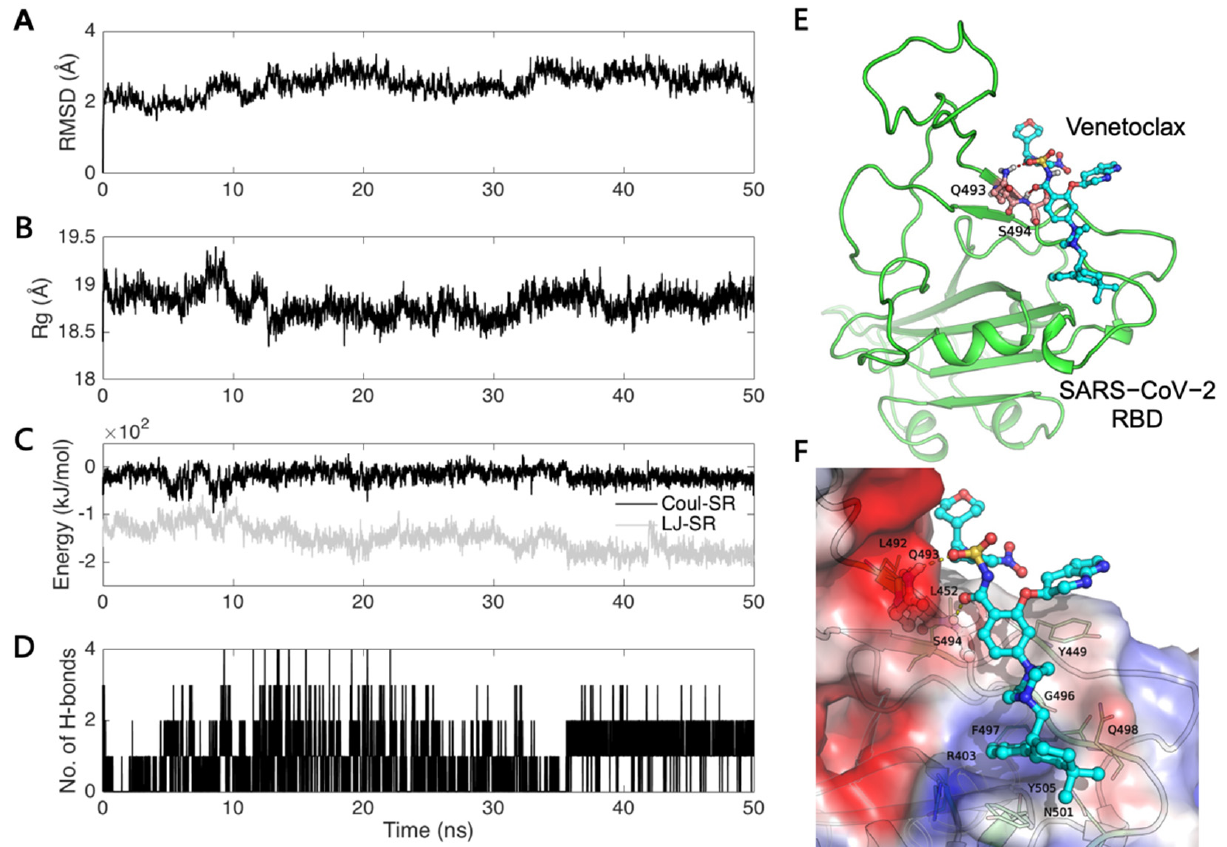
Figure 4. Analysis of the S1-RBD:Venetoclax MD simulation. The trajectory analysis of ( A ) the backbone RMSD and ( B ) the radius of gyration (Rg). ( C ) Coulomb-SR and Lennard-Jones-SR interaction energies, and ( D ) the number of hydrogen bonds of the S1-RBD:Venetoclax interface. ( E ) The last conformation of the 50 ns trajectories of the S1-RBD (green):Venetoclax (cyan) complex. The hydrogen bonds forming residues are highlighted with a ball and stick. ( F ) A close-up view of the S1-RBD:Venetoclax interface. The electrostatic potential surface of the S1-RBD:Venetoclax interface is also shown (blue: positive charge; white: hydrophobic; red: negative charge). The last conformation of the 50 ns trajectories of the S1-RBD:Venetoclax complex was chosen for the following interaction analysis (Figure 4E). The hydrogen bonds forming residues (Q493 and S494) are highlighted with a ball and stick. The key residues stabilizing the binding sites of S1-RBD:Venetoclax are identified, and the electrostatic potential surface of the S1-RBD:Venetoclax interface is also shown (Figure 4F). We found that the amino acids Q493 and S494 involved in the formation of hydrogen bonds may play an important role in the stabilization of the binding site of